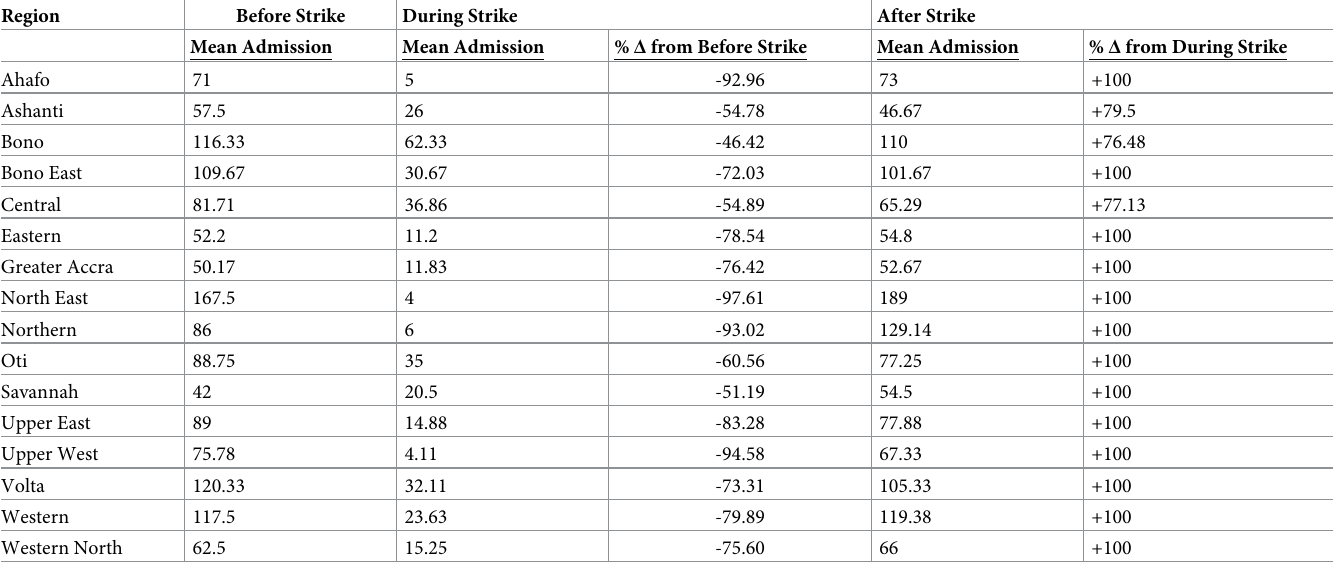
Table 3. Percentage change in the mean admissions during and after strike. Region Before Strike During Strike